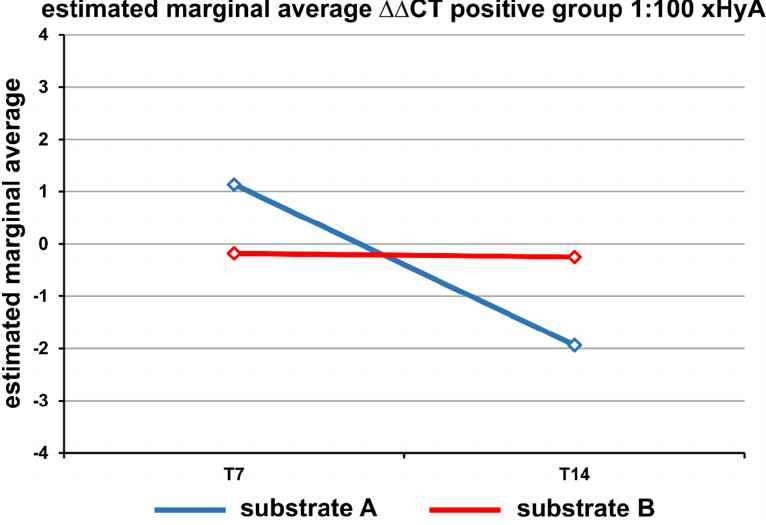
Figure 4. The statistically significant difference in the - ΔΔ CT scores between the two substrates.